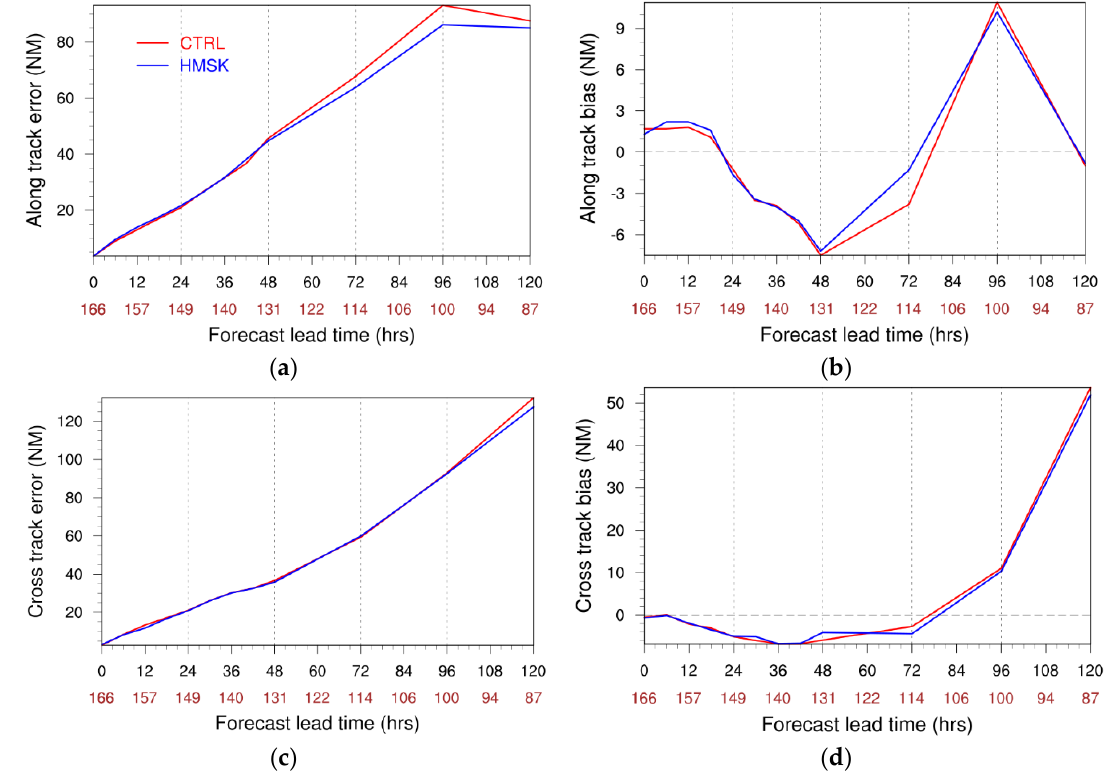
Figure 9. Performance comparison of along- and cross-track forecasts between CTRL (red) and HMSK (blue) from four selected Atlantic hurricanes in 2017–2018. ( a ) Along-track forecast error, ( b ) along-track bias; ( c ) cross-track forecast error, and ( d ) cross-track bias.